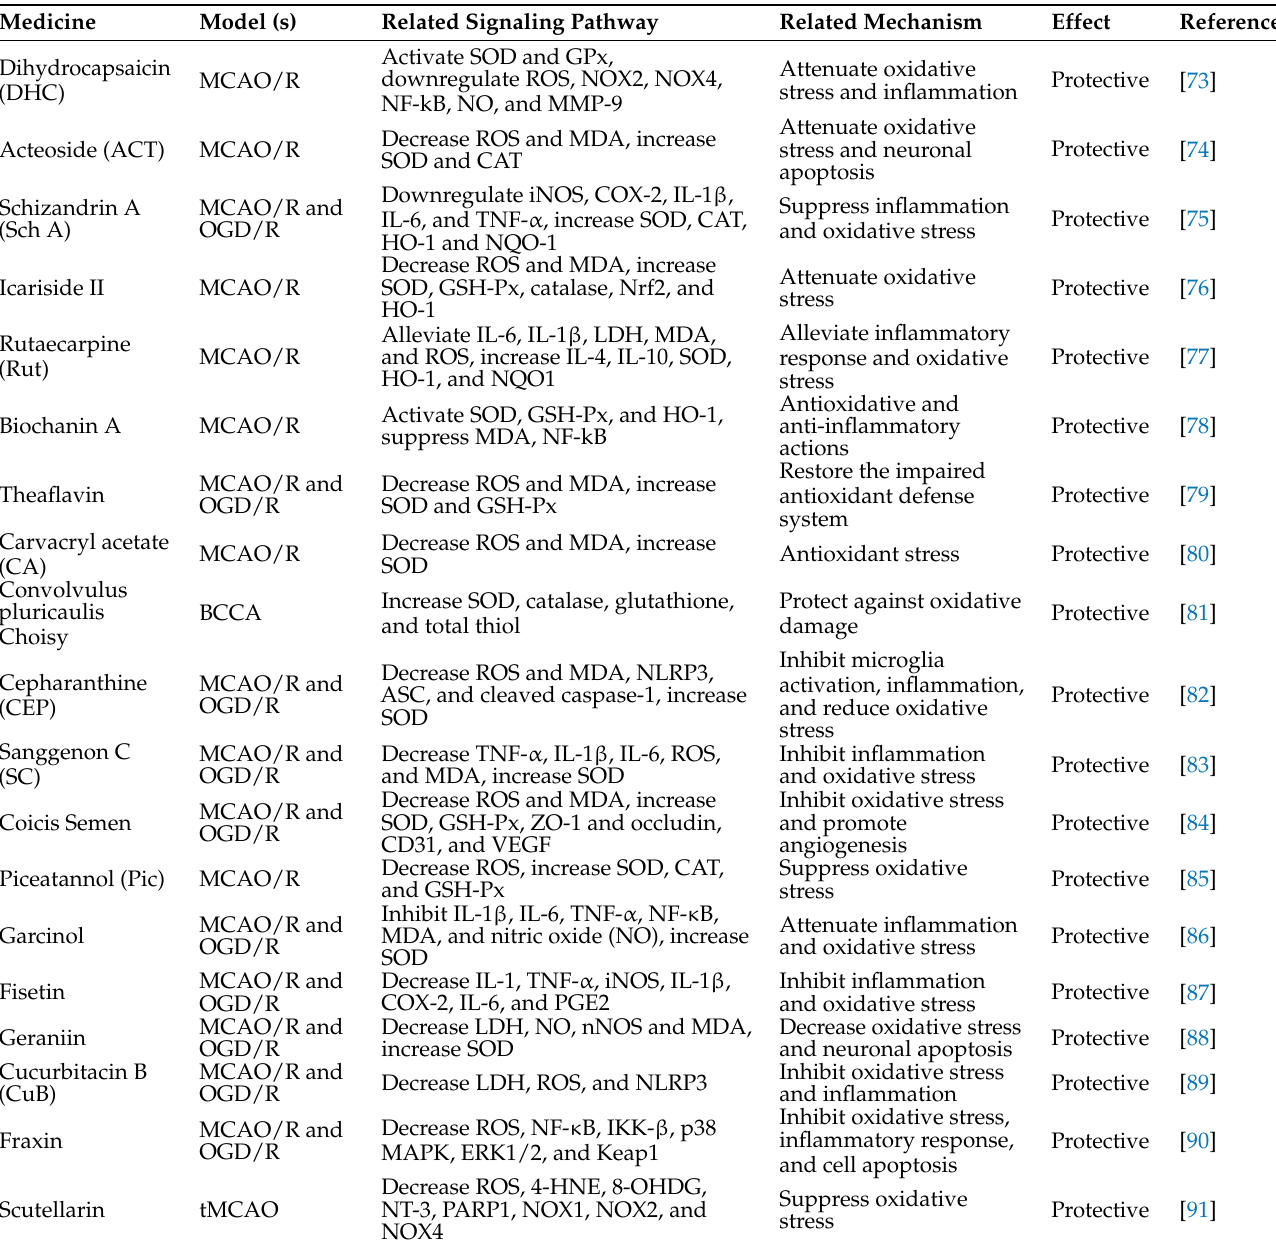
Table 1. Several traditional Chinese medicine/compounds affect cerebral ischemic stroke by regulat- ing Nrf2 signaling